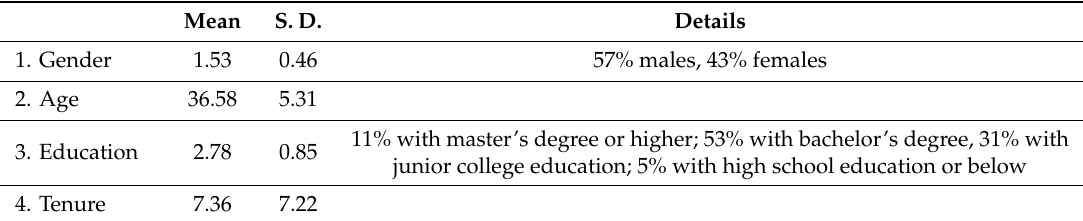
Table 2. Description of dropping out